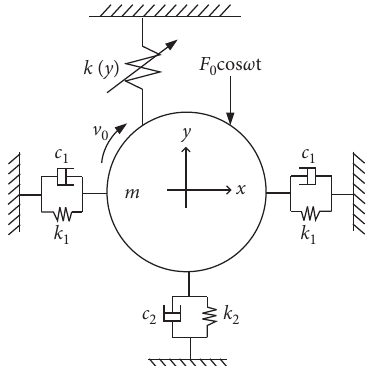
Figure 6: Nonlinear coupled vibration model of hot rolling mill